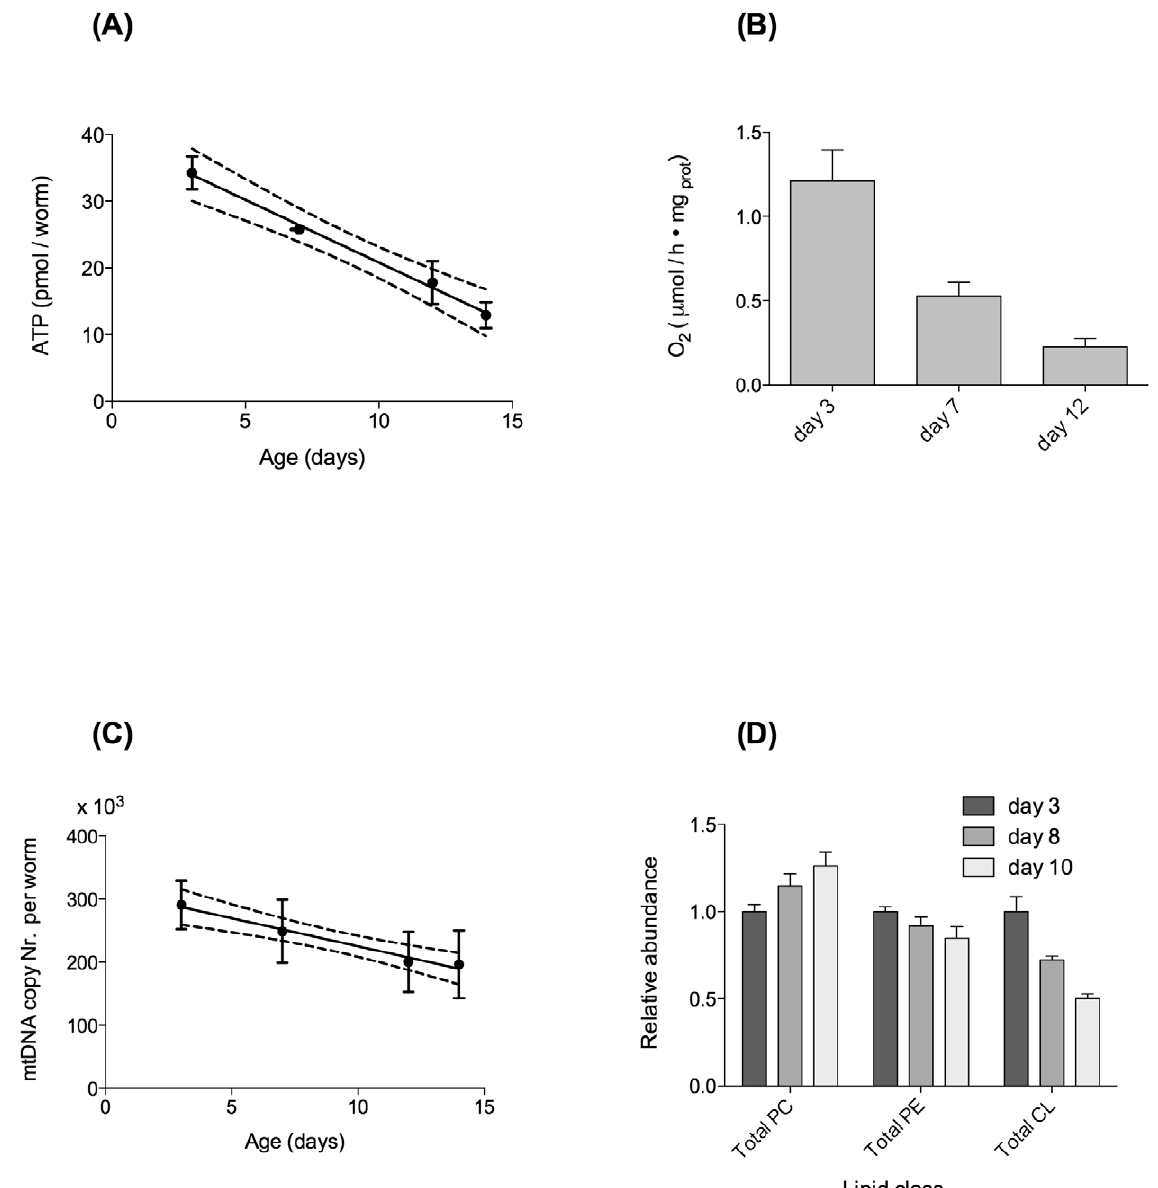
Figure 2. Metabolic parameters decline linearly with age in a typical JK1107 cohort. ( A ) Age-dependent decline in ATP content and linear regression. Best linear fit (R squared 0.86) and 95% confidence band. Slope statistically significantly different from zero (P , 0.0001). ( B ) Age- dependent decline in oxygen consumption, normalised to worm protein. Decline in oxygen consumption was statistically significant (P=0.003, ANOVA with Tukey’s post-test). ( C ) Age-dependent decline in mtDNA copy number per worm and linear regression. Best linear fit (R squared 0.98) and 95% confidence bands. Slope statistically significantly different from zero (P , 0.01). ( D ) Age-dependent loss of the mitochondrial membrane lipid cardiolipin in C. elegans total lipid extract (n=3 independent extractions for each time point). Total CL content clearly declines with age (P , 0.005). Lipid content is expressed as relative abundance of phosphatidylcholines (PC), phosphatidylethanolamines (PE) and Cardiolipin (CL), normalised to PC content of young worms.